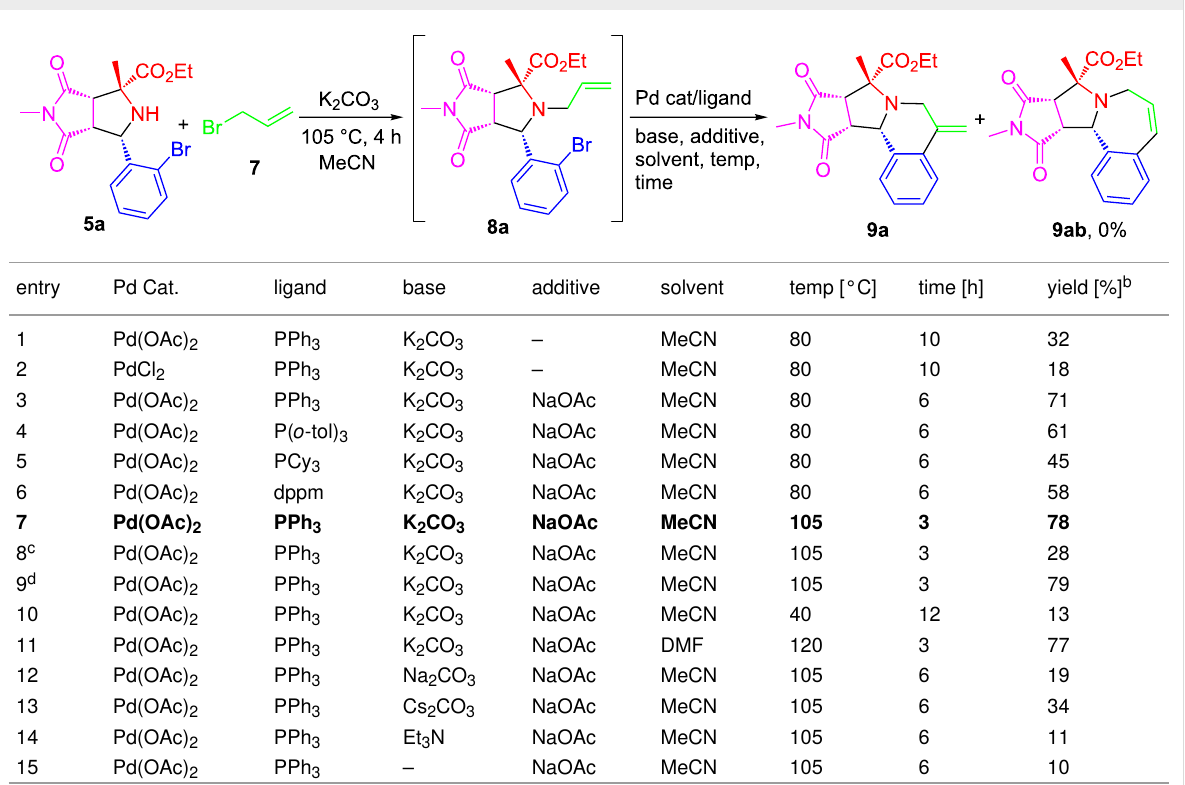
Table 1: Optimization of the one-pot reaction conditions. a